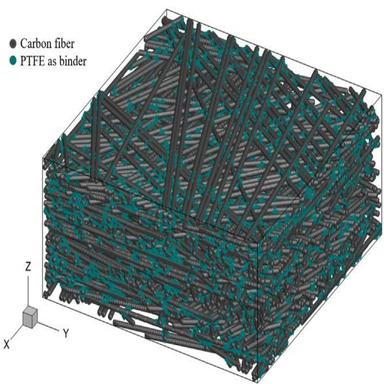
(a) Relative gradient errors for the porous composite transport media as a function of the window length and (b) the isometric view of a randomly generated porous transport layer.